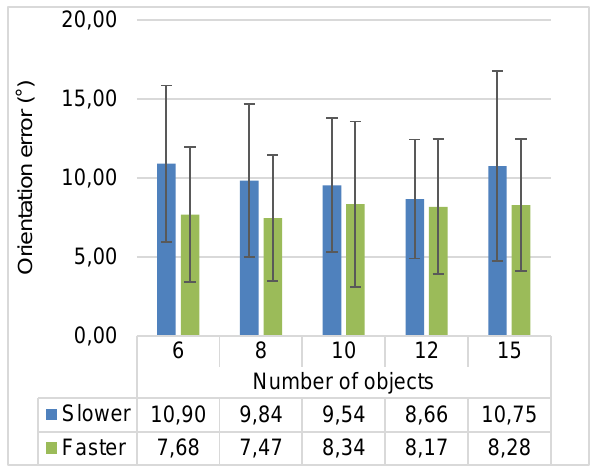
Figure 4: Mean of orientation error in the experimental groups for filtered